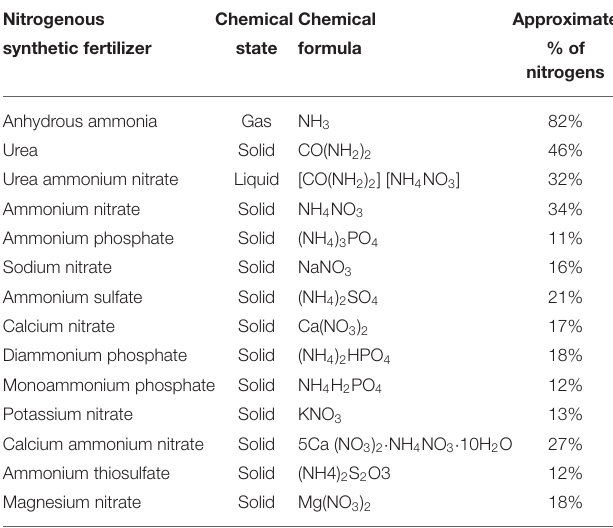
TABLE 1 | Nitrogen content of nitrogen-based synthetic